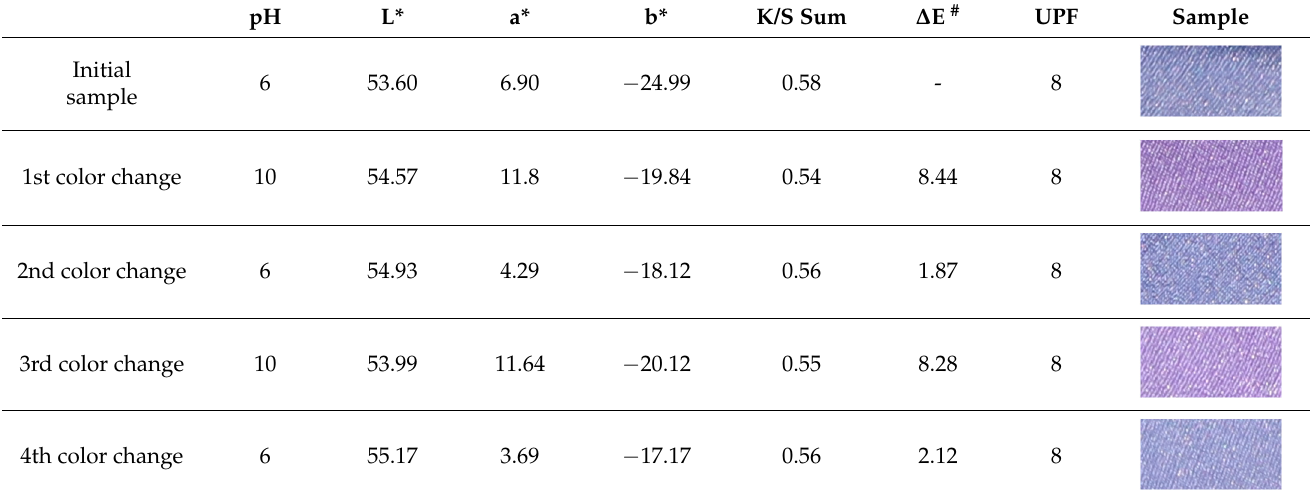
Table 9. Color coordinates (L*-lightness, a*-yellowness/blueness, and b*-redness/greenness), K/S, ∆ E and UPF of the samples.